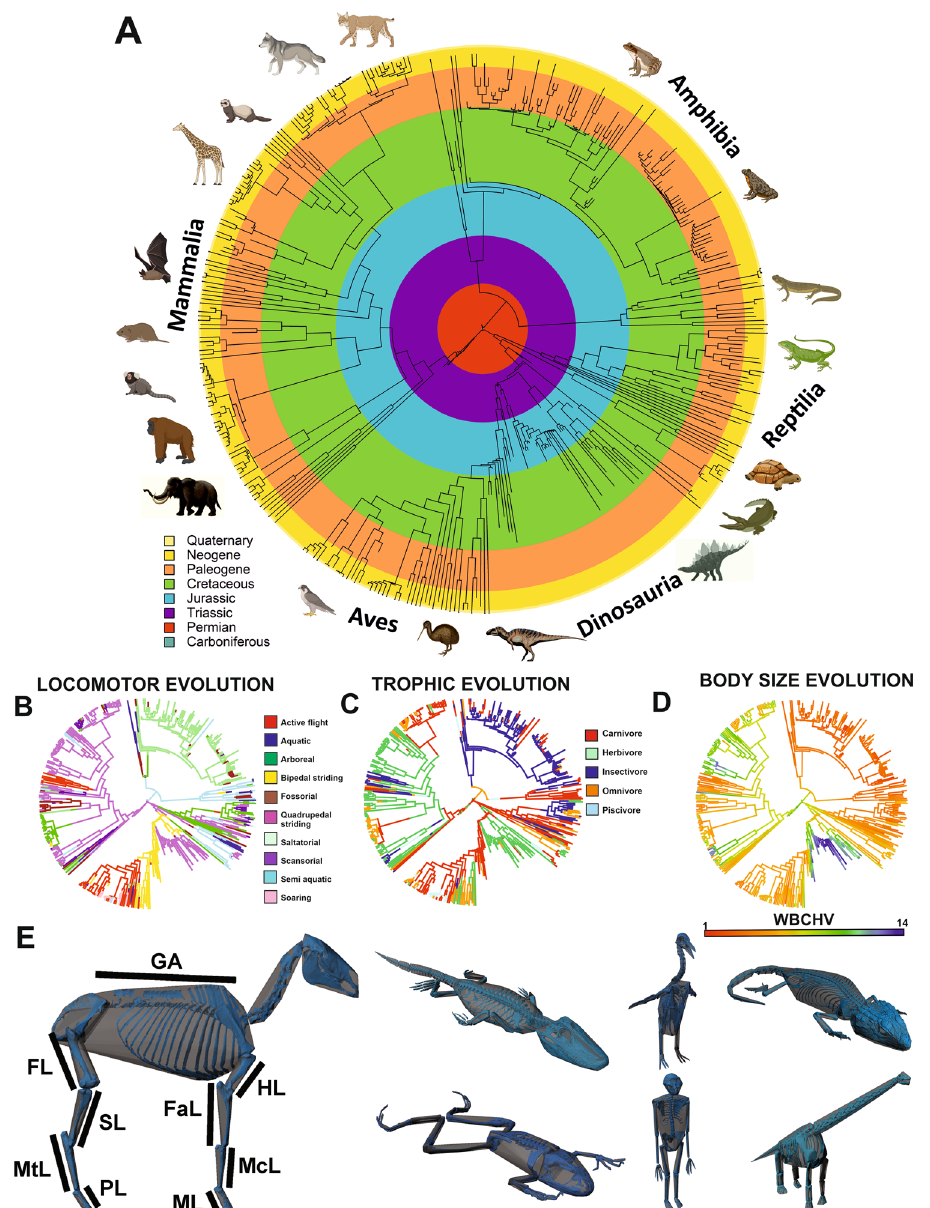
Fig.1|Bodysize,shapeandecologyintetrapods. Toinvestigatetheevolutionof body shape and ecology intetrapods we assembled a data set of A 410 extinctand extantterrestrialvertebratesfromacrossTetrapodathatcapturedmajorevolution changes in B locomotor and C trophic ecology and D body size. E From 3D digital skeletal models of these taxa we extracted a range of linear and volumetric mea- suresandusedthemtoderivemeasuresofbodysizeandshapeusingphylogenetic